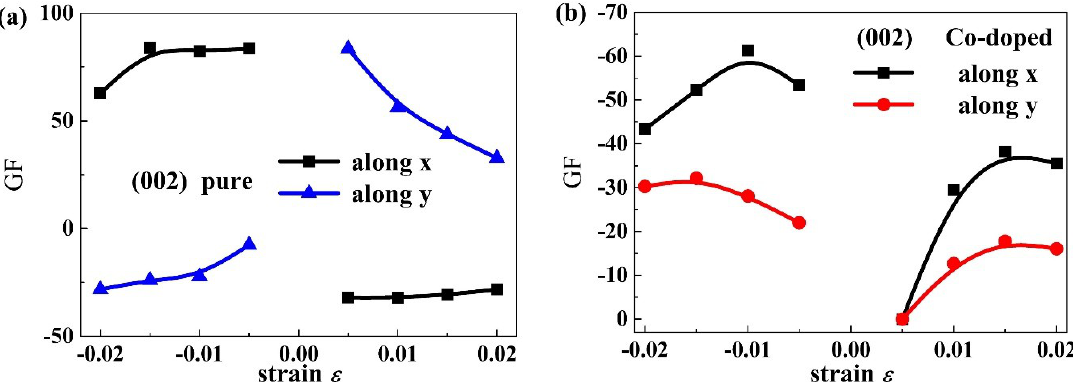
Figure 10. The intrinsic charge carrier concentration ratio ( n ε − n 0 ) / n 0 as a function of strain for ( a ) PbPdO 2 , and ( b ) PbPd 0.75 Co 0.25 O 2 along the a-axis (called x) and b-axis (called y) with ε = − 0.02 and 0.02. The inset shows a magnification curve with strain ranges from − 0.015 to 0.015.